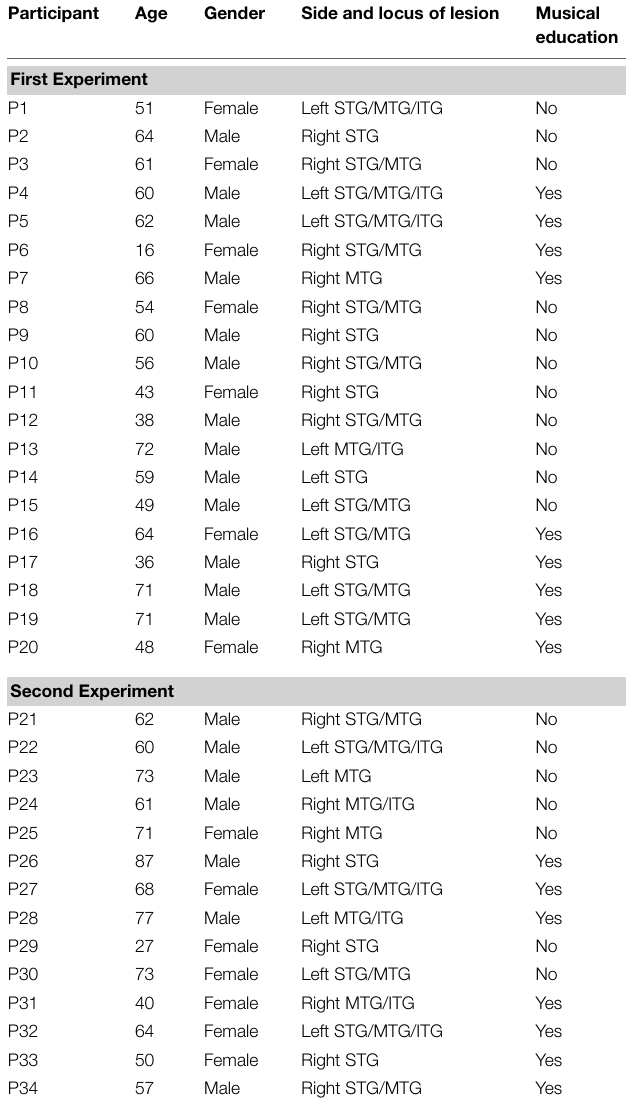
TABLE 1 | Individual data of patients (Age: years; Side and locus of lesion: Left (left-sided), Right (right-sided), STG (superior temporal gyrus), MTG (middle temporal gyrus), ITG (inferior temporal gyrus); Musical education: No (no musical education except in school), Yes (previous musical training instrumental or